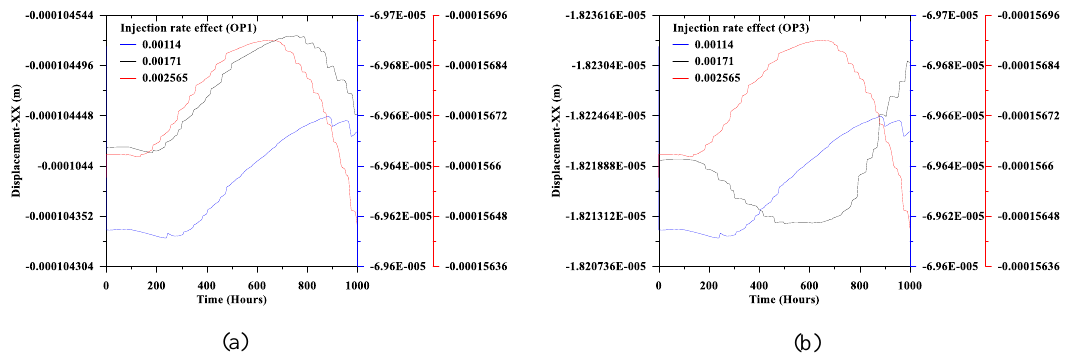
ff ect on the x -axis displacement: ( a ) OP1 and ( b ) Figure 15. Injection rate effect on the x -axis displacement: ( a ) OP1 and ( b ) OP3. Figure 15. Injection rate e